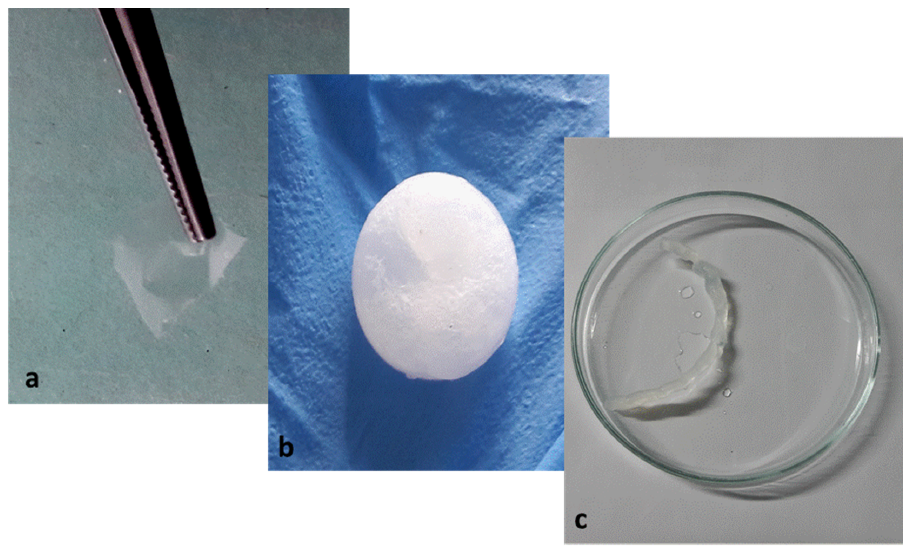
Figure 12. Examples of objects based on phosphorylated regenerated cellulose: ( a ) regenerated film from 2 wt% cotton fibers in [DIMIM][(MeO)(H)PO 2 ], ( b ) regenerated bead, and ( c ) regenerated yarn from 5 wt% cotton fibers in [DIMIM][(MeO)(H)PO 2 ].